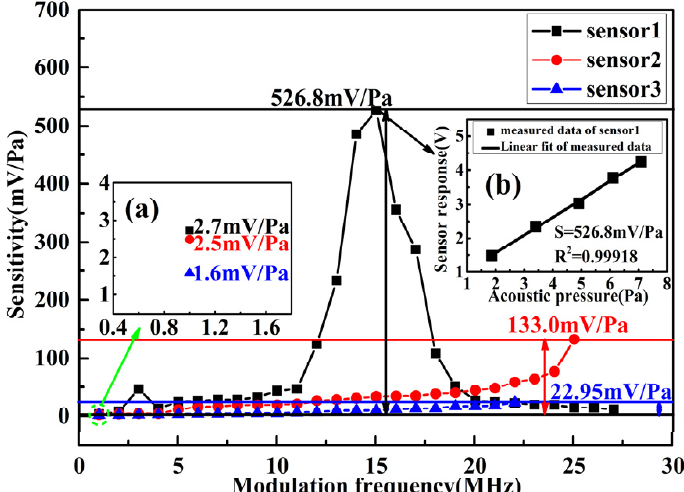
Figure 11. The sensitivity characteristics of the three FOASs when the modulation frequency changes from 1 MHz to 27 MHz. The inset ( a ) shows the sensitivities of the three sensors at a modulation frequency of 1 MHz, and the inset ( b ) shows the sensitivity test data and linear fitting result of sensor 1 at the modulation frequency of 15 MHz.